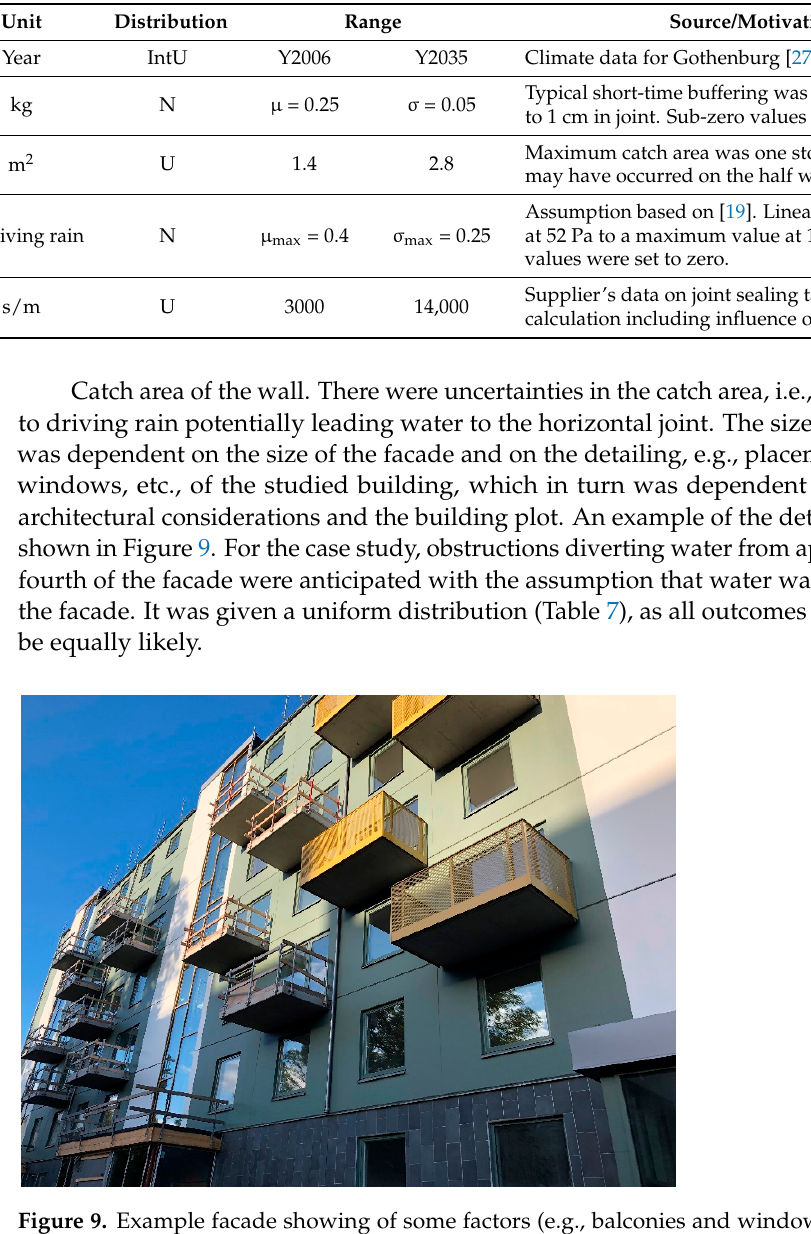
Table 7. Parameters of stochastic representation used in simulations.